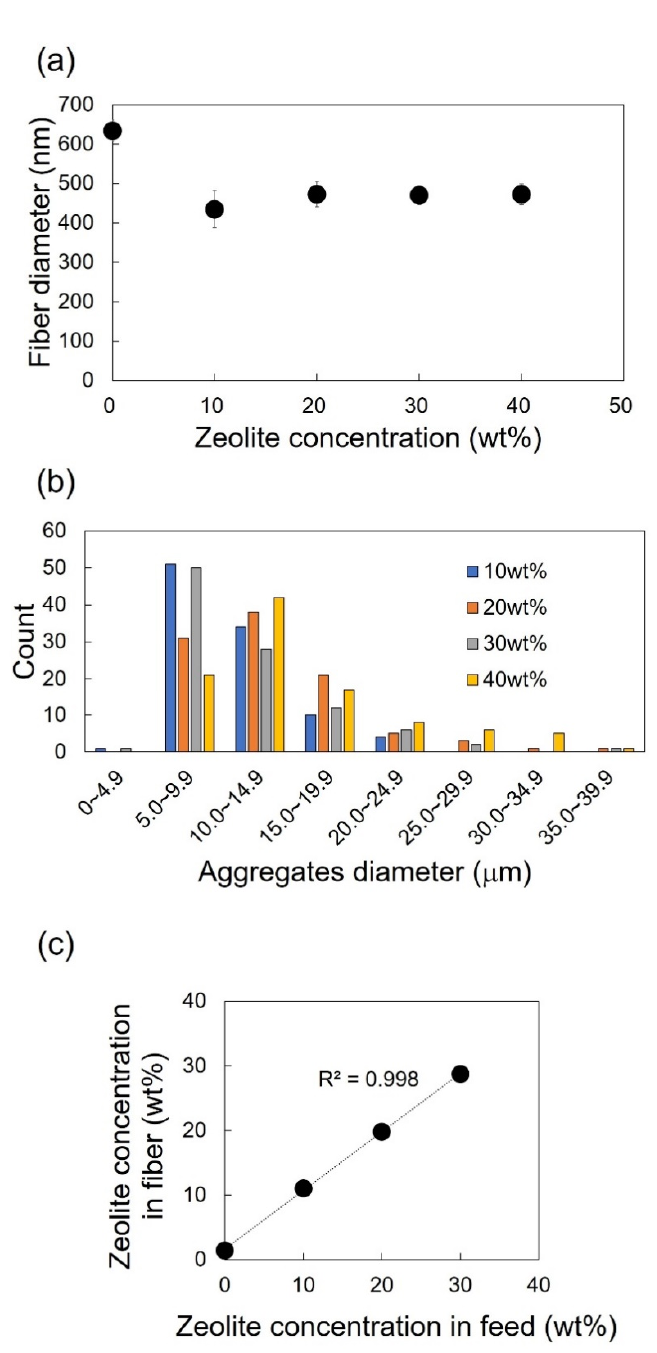
Figure 3. ( a ) Fiber diameters of the electrospun 7H240 zeolite/EVOH at 0 to 40 wt% zeolite from SEM images ( n = 40). ( b ) Diameters of the zeolite aggregates in the electrospun 7H240 zeolite/EVOH nanofiber mesh from SEM images ( n = 100). The zeolite concentrations are 10 (blue), 20 (orange), 30 (grey), and 40 wt% (yellow). ( c ) The zeolite concentration of the electrospun 7H240 zeolite/EVOH nanofiber mesh according to TGA ( n = 3). The x axis shows the zeolite concentrations in the feed before electrospinning.